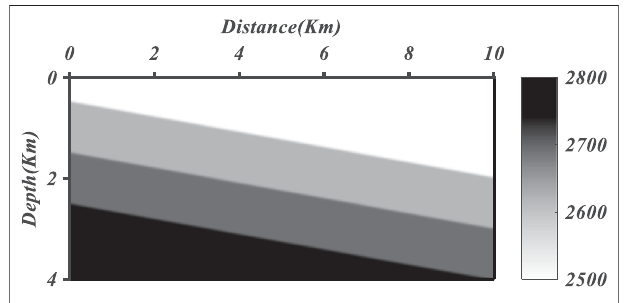
FIGURE11| TheP-wavevelocityofthefour-layerinclinedmodel,whose S-wave velocity and density are satis fi ed with v s (cid:1) v p /1 . 73 and ρ (cid:1) 2300 g / cm 2 , respectively.